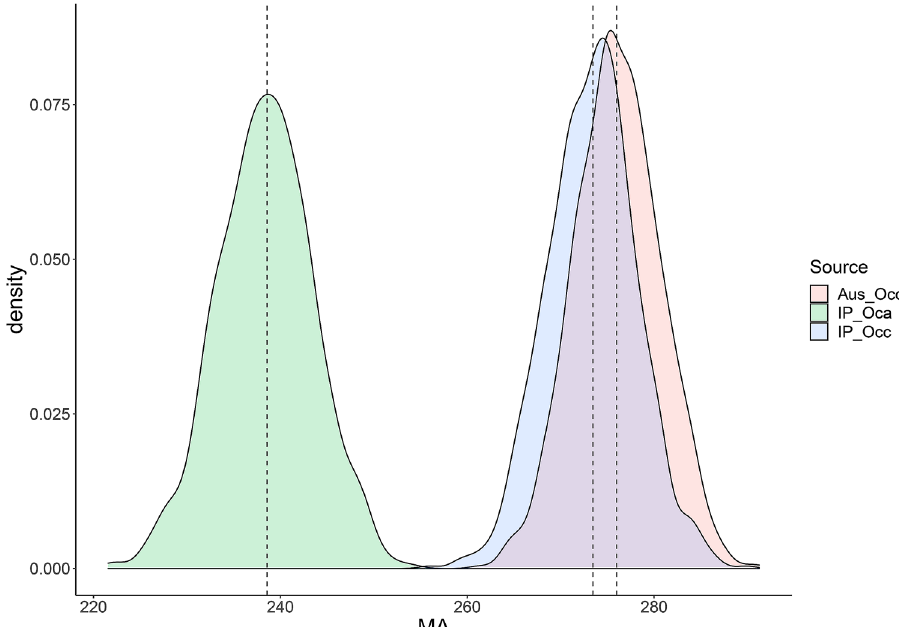
Figure 2. Estimated densities for the maximum asymptotic value of the growth curve of dry eye lens (MA) for Oryctolagus cuniculus algirus (Oca) and Oryctolagus cuniculus cuniculus (Occ) in the Iberian Peninsula (IP), and the latter subspecies in Australia (Aus). Dotted lines indicate the estimate of a for each